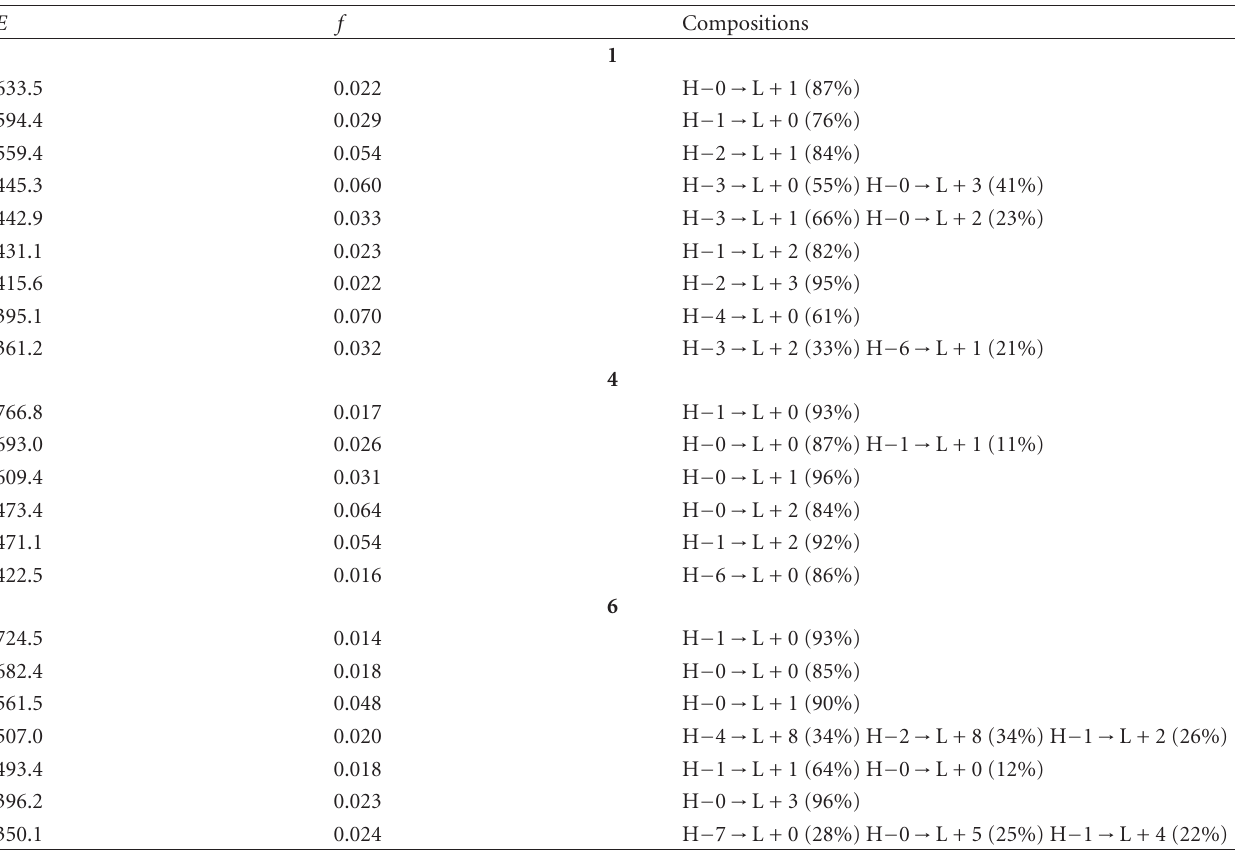
Table 3: Selected excitation energies (E, nm), oscillator strength ( f ), and relative orbital contributions of the absorption spectra of Fe(II)- based complexes calculated at the B3LYP/6-31G ∗ level in MeCN solution.